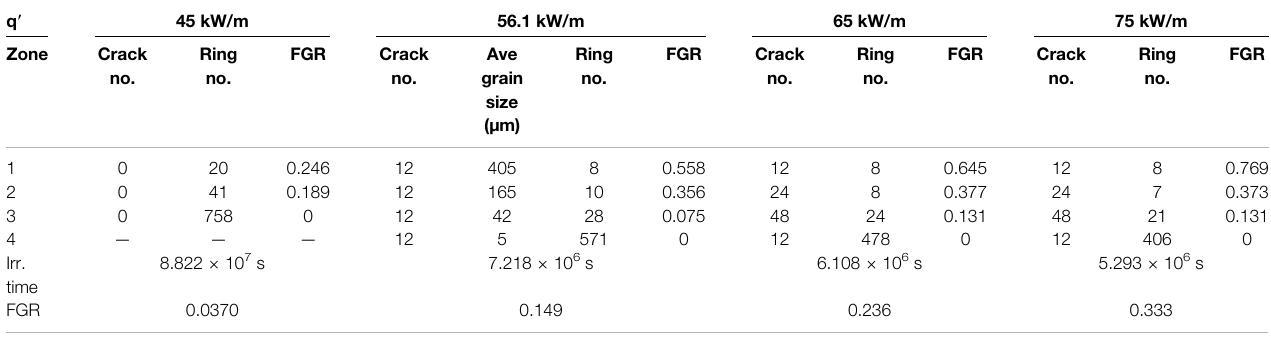
TABLE 2 | Calculated fractional gas release for various linear heat generation conditions (Kim et al., 1996). 45